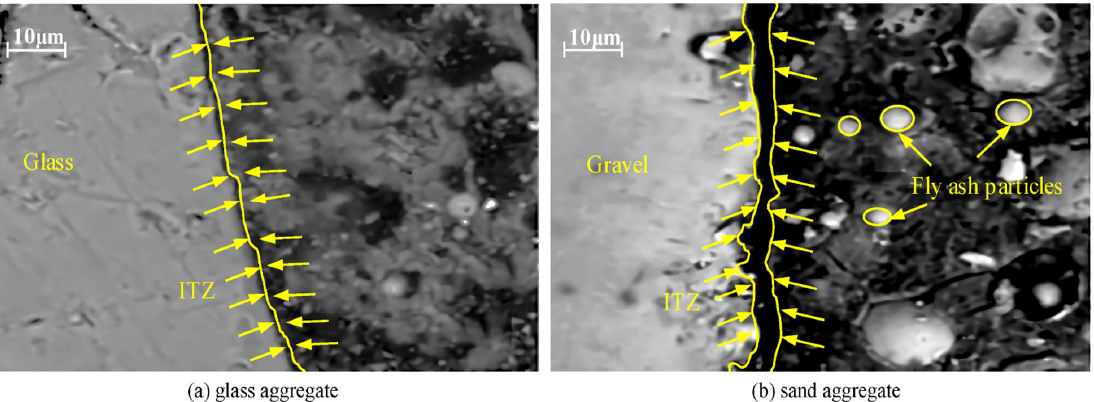
Figure 23. FA ‐ GP concrete SEM images with several types of aggregates: ( a ) the interface of the glass aggregate and GP; ( b ) the interface of the sand aggregate and GP. Adapted from [258,259].